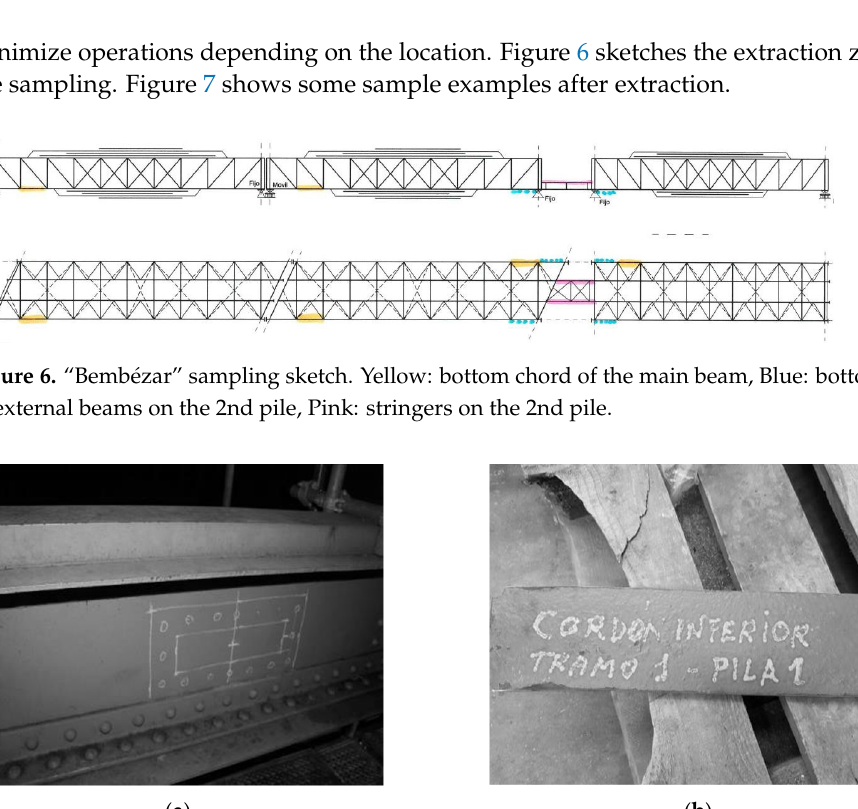
Table 2. Experimental design and testing summary.